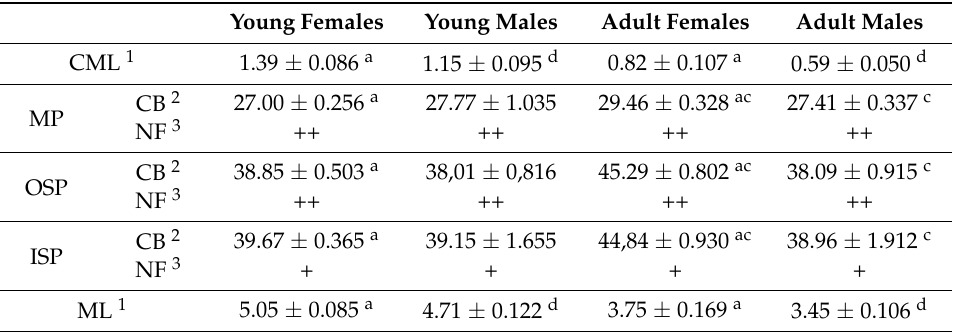
Table 1. The calcitonin gene-related peptide (CGRP)-like immunoreactive (CGRP-LI) perikarya and nerve fibers in the porcine descending colon under physiological conditions in young (10-week old) females and males and adult (6–8 months old) females and males. Young Females Young Males Adult Females Adult Males CML 1 1.39 ± 0.086 a 1.15 ± 0.095 d 0.82 ± 0.107 a 0.59 ± 0.050 d CB 2 27.00 ± 0.256 a 27.77 ± 1.035 29.46 ± 0.328 ac 27.41 ± 0.337 c MP NF 3 ++ ++ ++ ++ CB 2 38.85 ± 0.503 a 38,01 ± 0,816 45.29 ± 0.802 ac 38.09 ± 0.915 c OSP ++ ++ ++ ++ CB 2 39.67 ± 0.365 a 39.15 ± 1.655 44,84 ± 0.930 ac ISP NF 3 + + + + ML 1 5.05 ± 0.085 a 4.71 ± 0.122 d 3.75 ± 0.169 a 3.45 ± 0.106